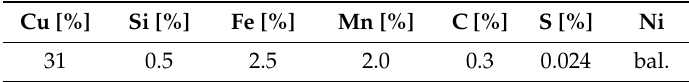
Table 1. Chemical composition of Monel 400.